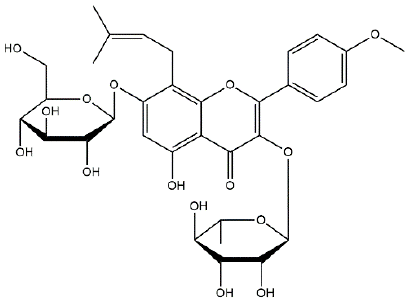
Figure 24. Schematic representation of the chemical structure of icariin (Ic).